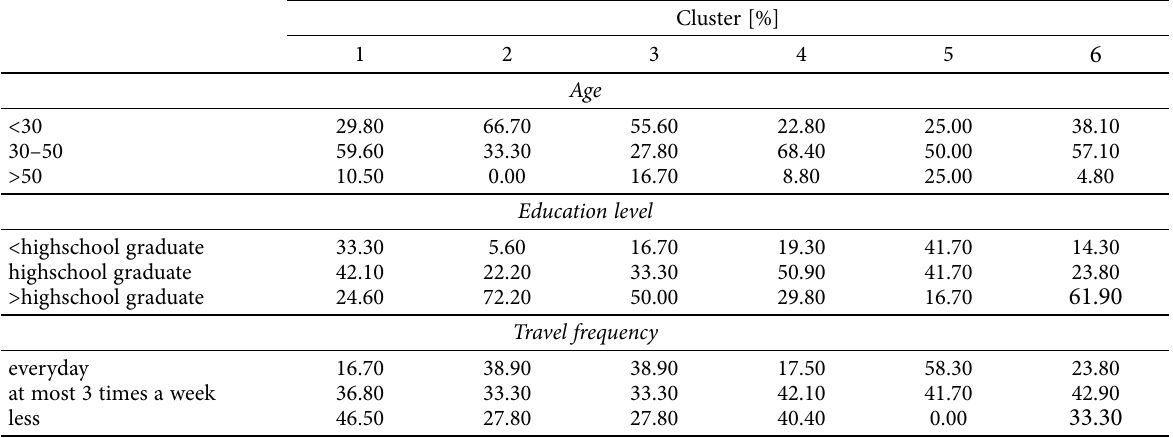
Table 18. Cluster analysis of demographic characteristics and travel